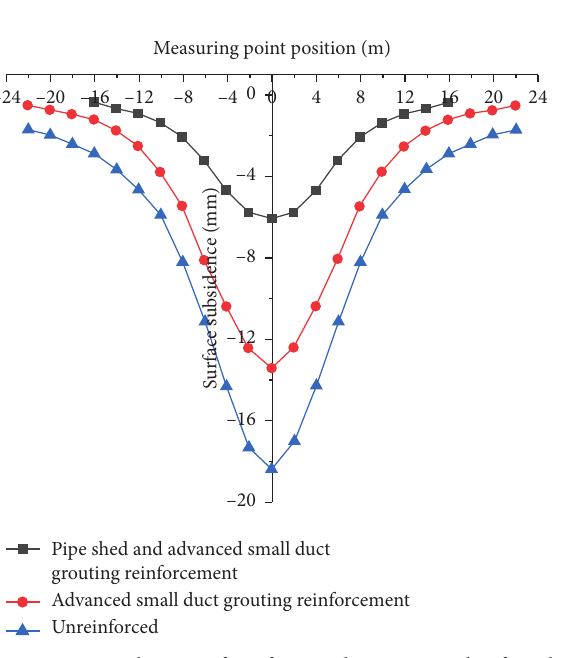
Figure 10: Distribution of surface settlement trough after the excavation of annular soil.